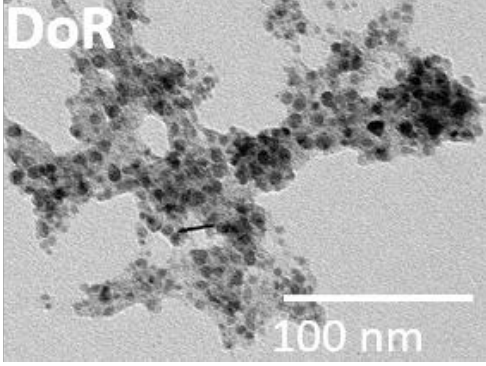
Figure 2. TEM image of the DoR sample.